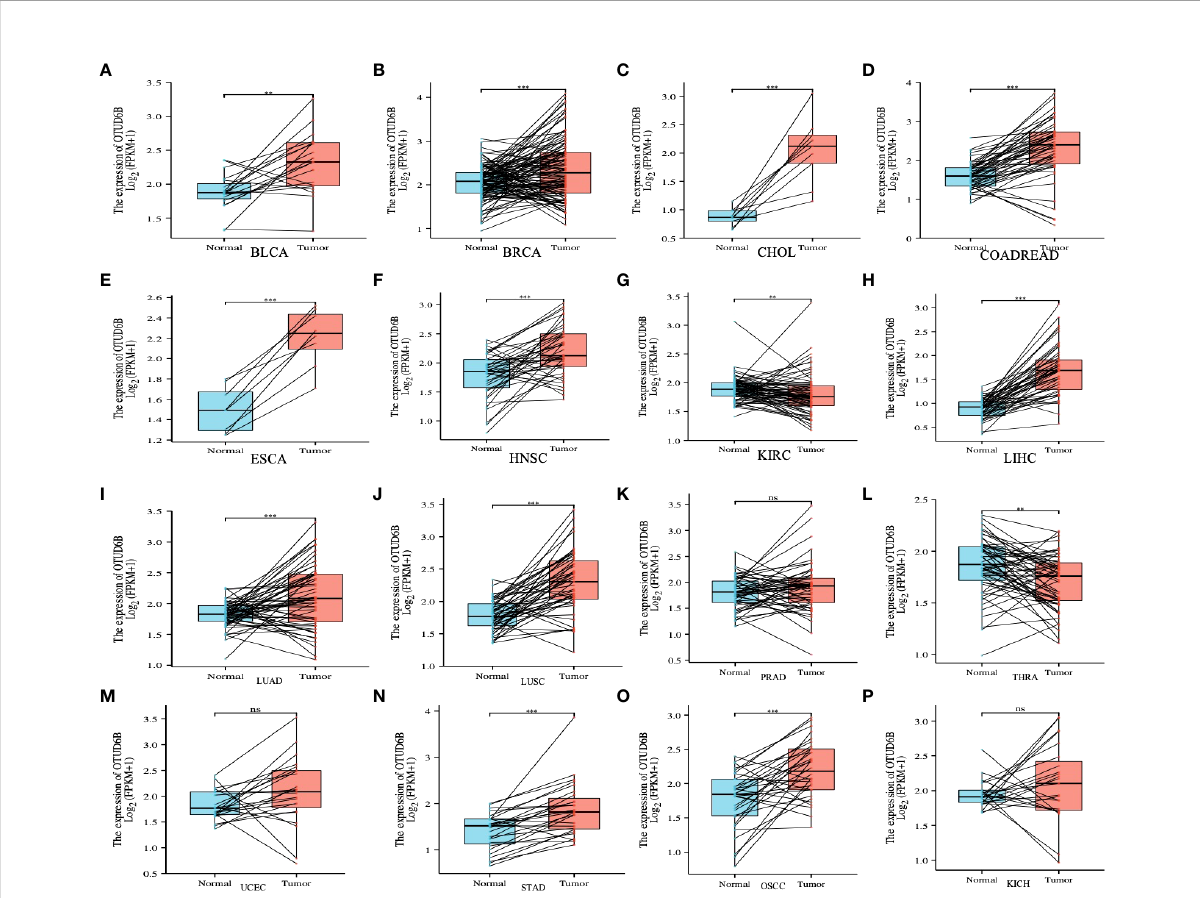
FIGURE 2 OTUD6B expression in pan-cancer. (A-P) Differential expression of OTUD6B in paired tumors and adjacent normal tissues from TCGA database (Ns, non-signi fi cant, **p < 0.01, ***p <